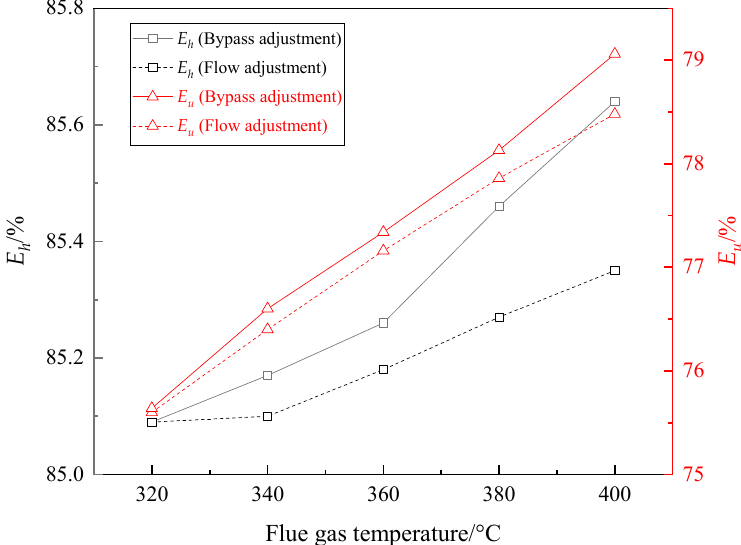
Figure 14. E h and E u as flue gas temperature changed.